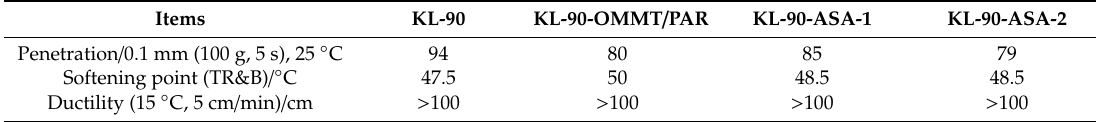
Table 10. Three indices of asphalts modified by anti-stripping composite.